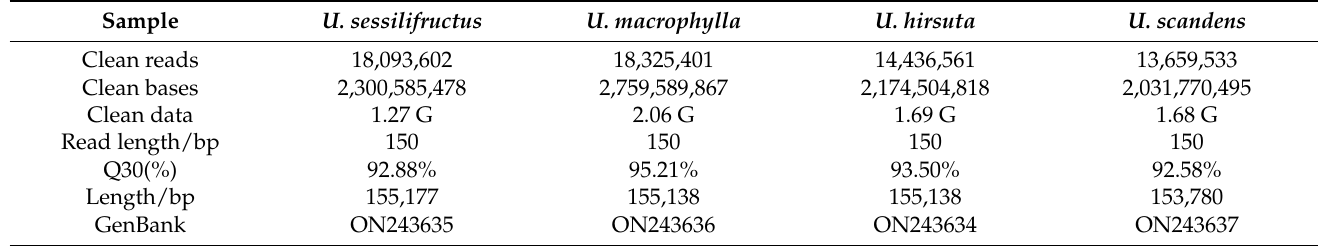
Table 1. Statistics of chloroplast genome sequencing of four species in Uncaria .